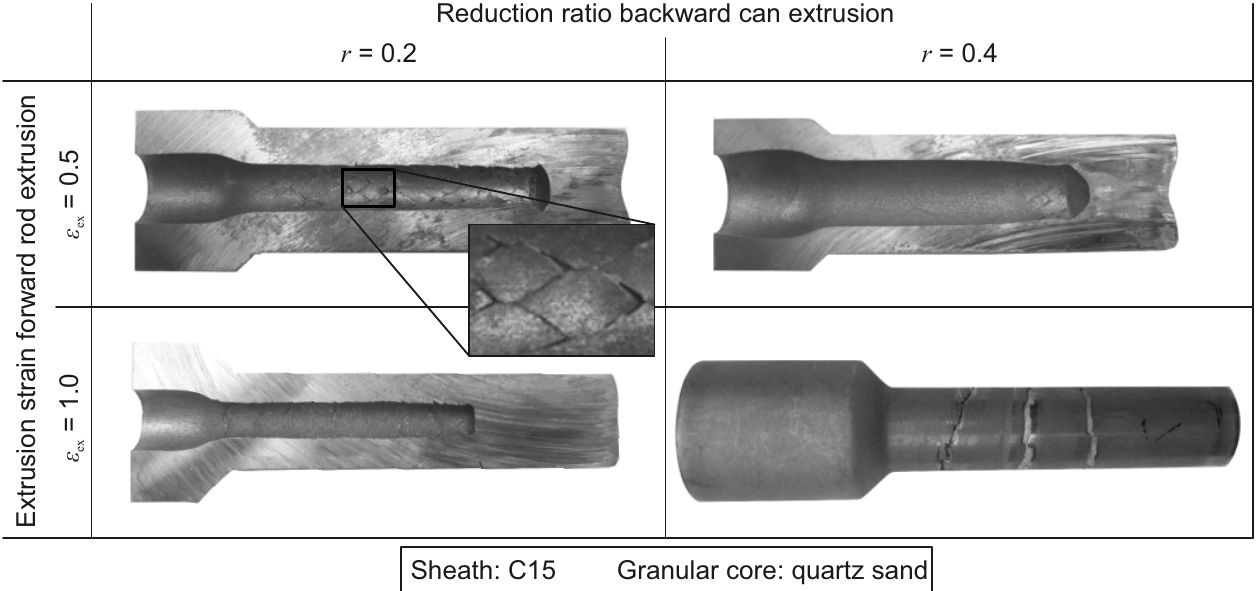
Figure 14. Hollow shafts produced by forward rod extrusion of steel cup billets filled with quartz sand, cut open to reveal inner